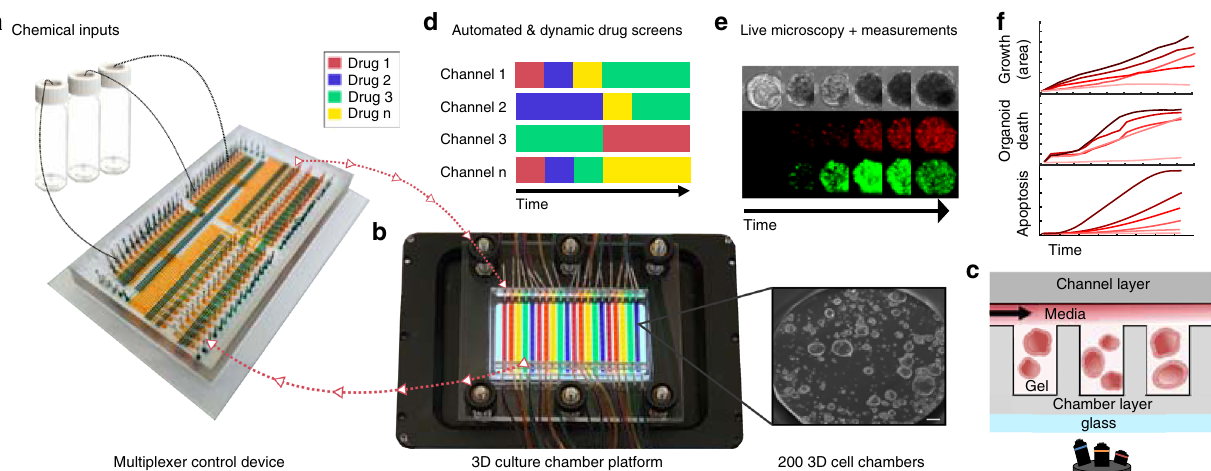
Fig. 1 Automated micro fl uidic 3D cellular and organoid culture platform for dynamical drug perturbations. a A programmable membrane-valve-based micro fl uidic chip (multiplexer control device) provides automated stimulation pro fi les to various chambers of a separate 3D culture platform ( b ) to produce many parallel and dynamical culture experiments. b , c The 3D culture chamber platform contains 200 individual chambers that are compatible with temperature-sensitive gels (i.e., Matrigel), and an overlaying channel layer enables 20 independent fl uidic conditions (scale bar 100 μ m). The channel layer is reversibly clamped on top of the chamber layer to provide media and other chemical stimulation without leakage. c A cross-section of the two-layer multichambered PDMS-based 3D culture chamber device. d 30 chemical inputs and 30 outlets of the multiplexer control device ( a ) are preprogrammed to provide combinatorial and time-varying stimulations to the 3D culture chamber device ( b ). e , f Organoids or 3D cellular structures are continuously observed through time-lapse imaging for quanti fi cation; fl uidic culture conditions can be changed on demand. The 3D culture chamber device can also